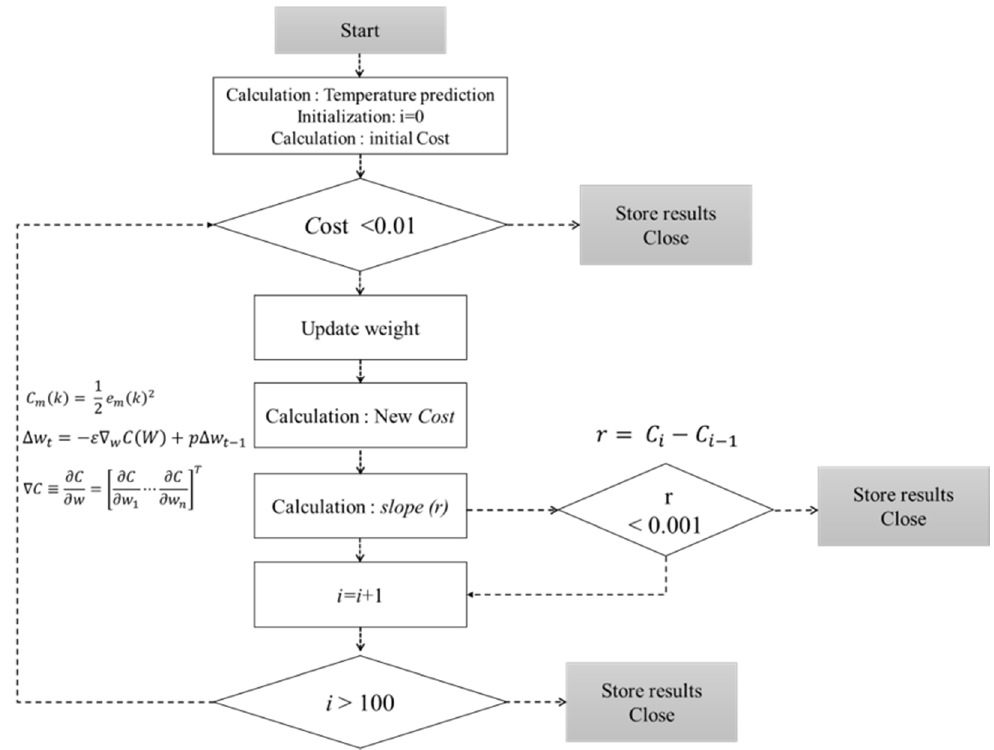
Figure 5. Flowchart for optimal control values using the gradient descent method.